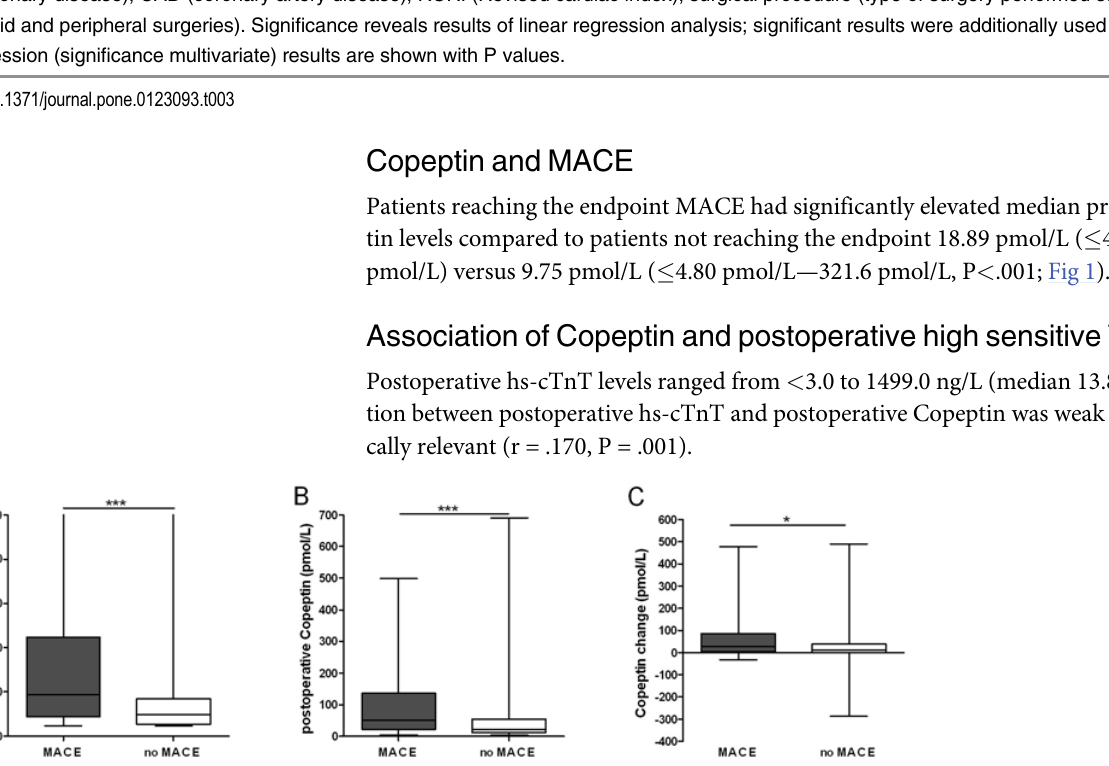
Patients reaching the endpoint MACE had significantly elevated median preoperative Copep- tin levels compared to patients not reaching the endpoint 18.89 pmol/L ( (cid:1) 4.80 pmol/L — 180.7